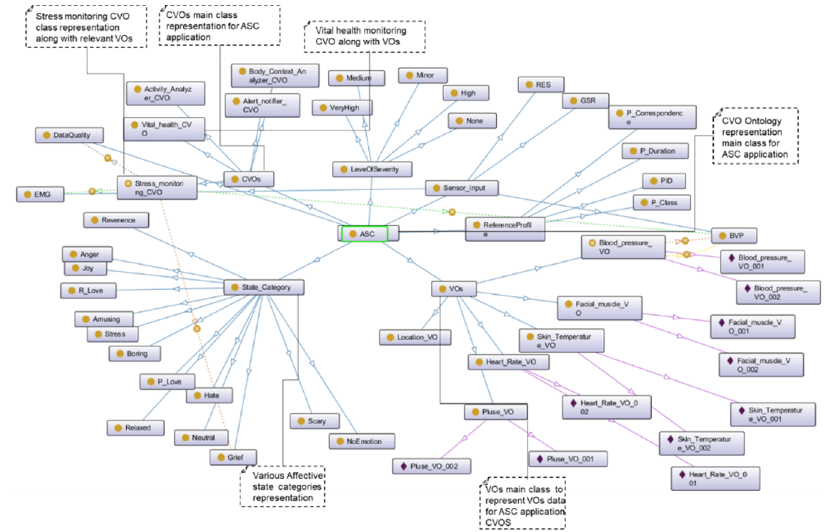
Figure 17. Affective Stress Care (ASC) application Virtual Objects (Vos) and Composite Virtual Objects (CVOs) ontology model.